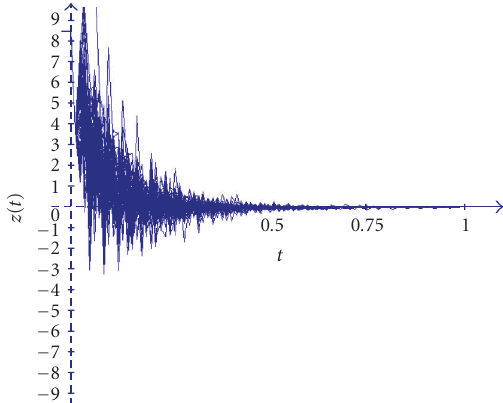
Figure 7.5 . Stable solution of (5.2) in the point X (160,100), a 0 = 8 .